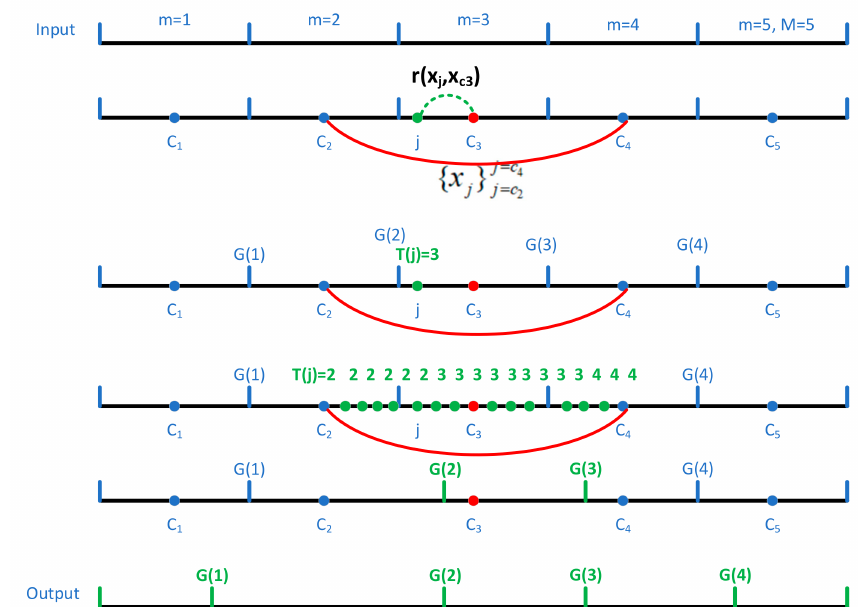
Figure 3. Example of hyperspectral image cube finely divided into 5